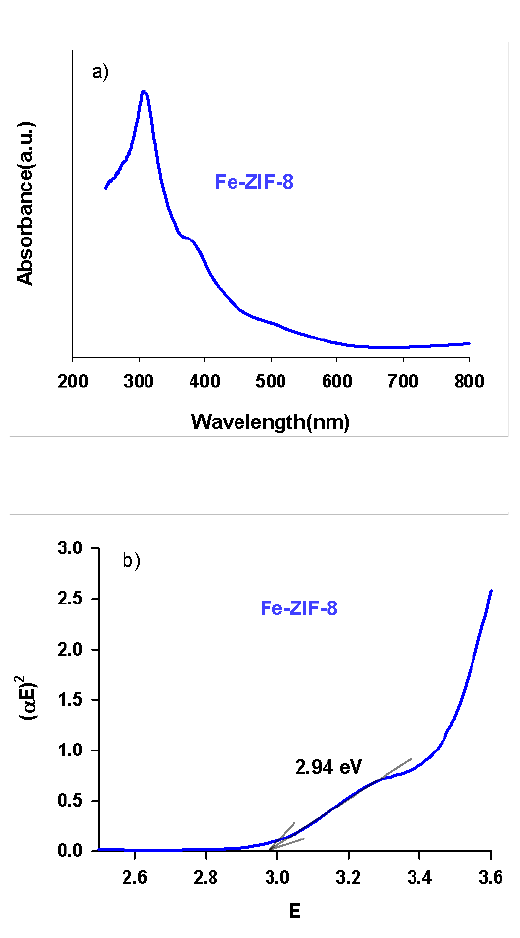
Fig. 5. The DRS results of Fe-ZIF-8 nanocatalyst: a) DR-UV–Vis spectrum and b) Tauc